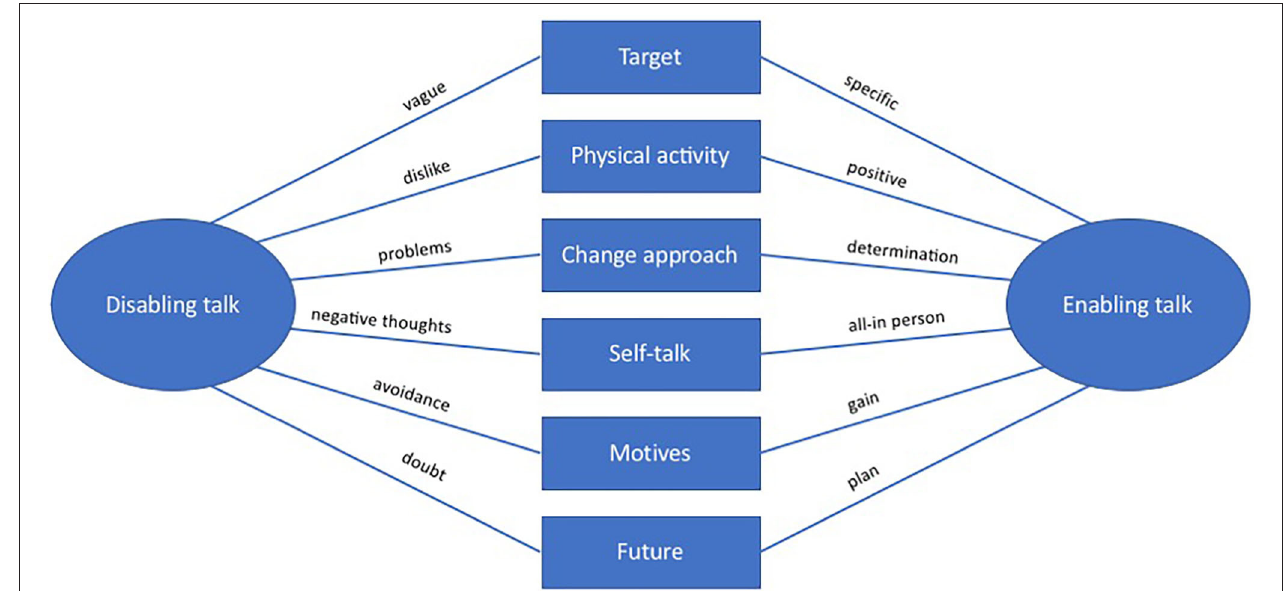
FIGURE 4 | Final thematic map of pre-interviews.